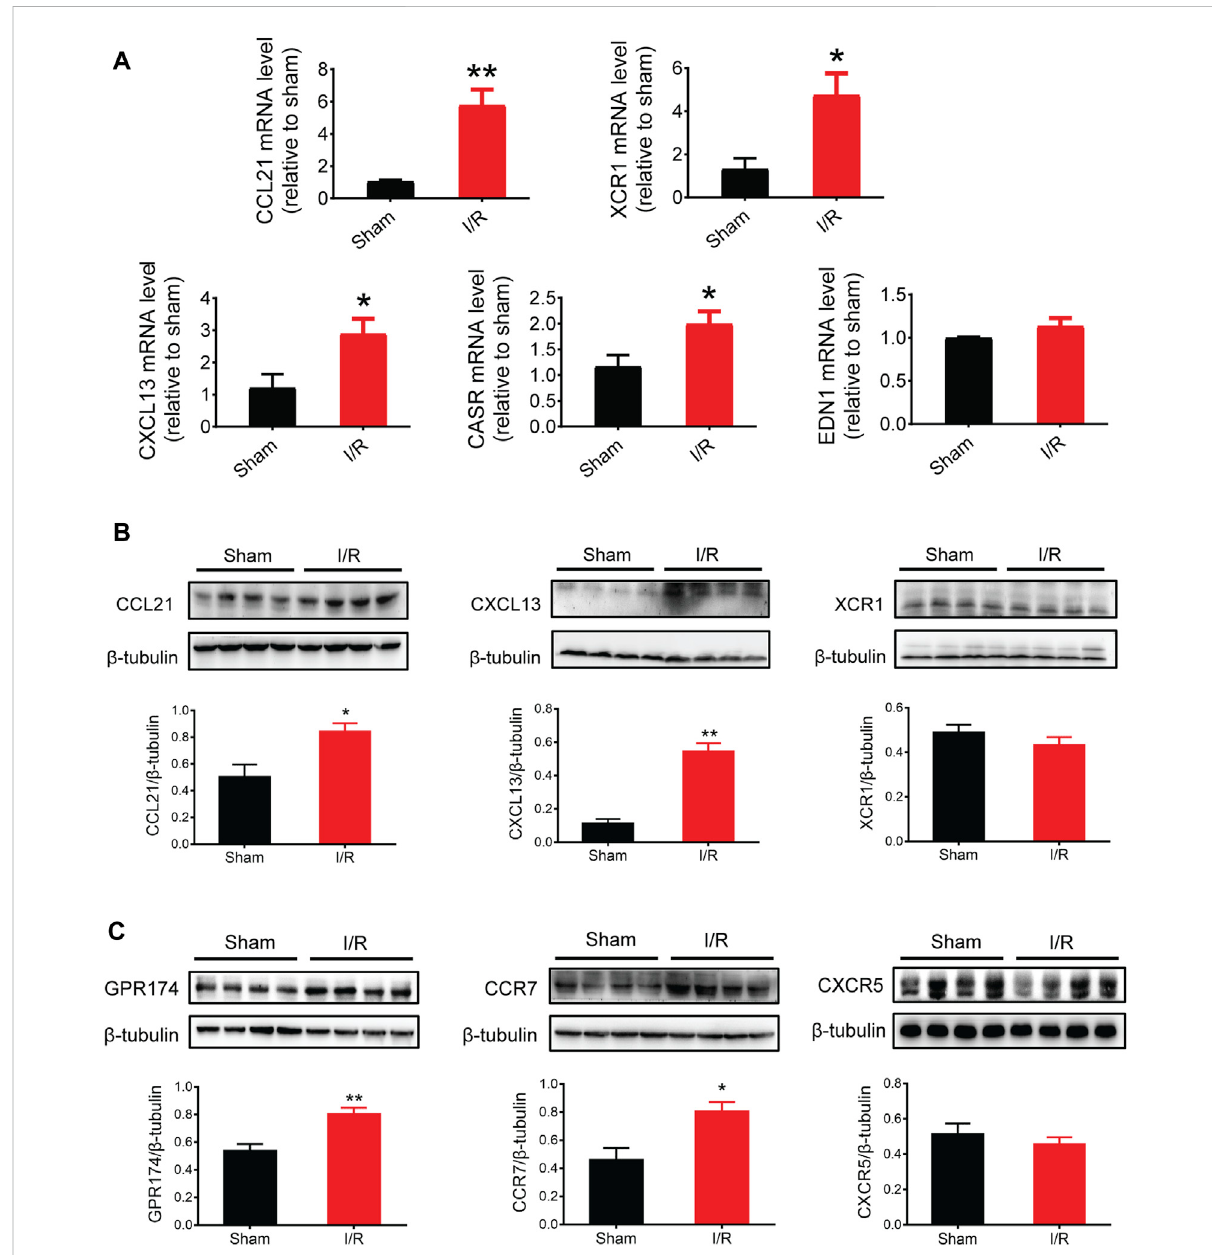
FIGURE 6 mRNA and protein expression of key genes and related receptors. (A) mRNA expression of CCL21, XCR1, CXCL13, CASR, and EDN1. (B) Protein expressionofCCL21,CXCL13,andXCR1. (C) ProteinexpressionofGPR174/CCR7(thereceptorsofCCL21)andCXCR5(thereceptorsofCXCL13). n